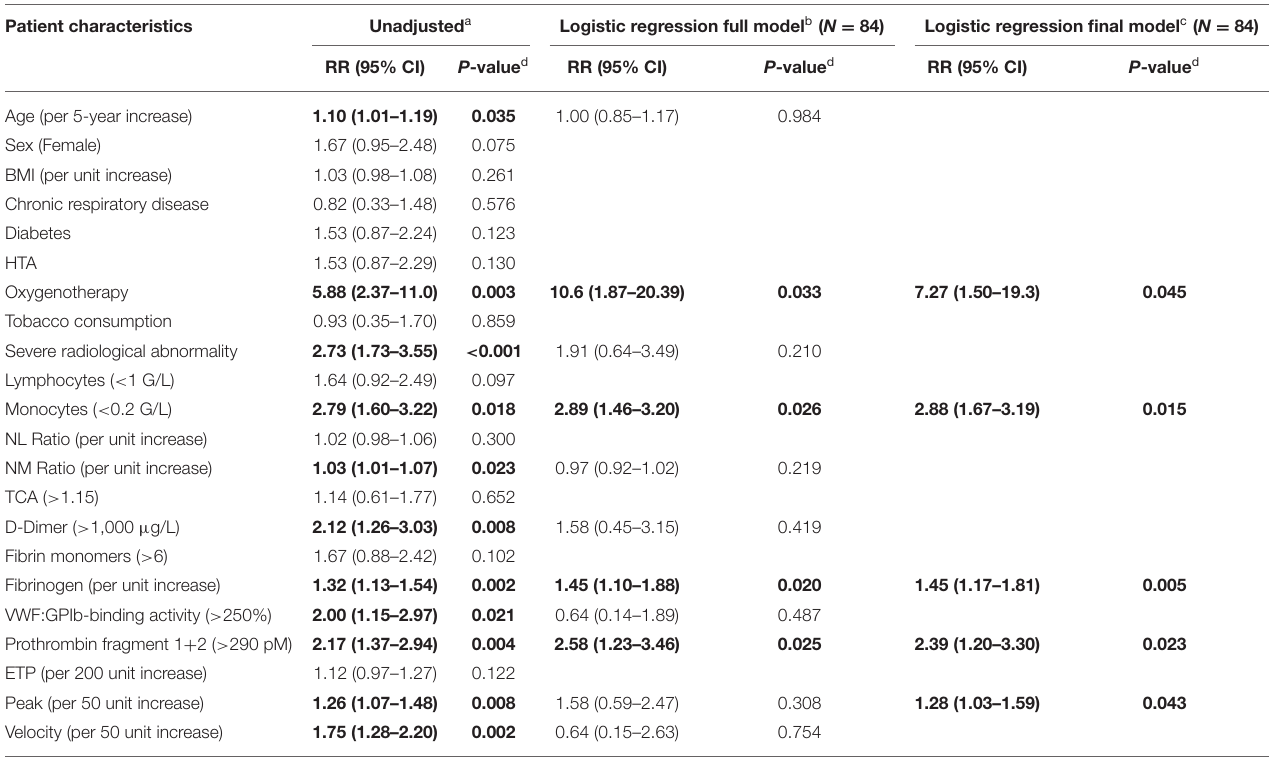
TABLE 2 | Association factors with clinical worsening (death or intensive care unit